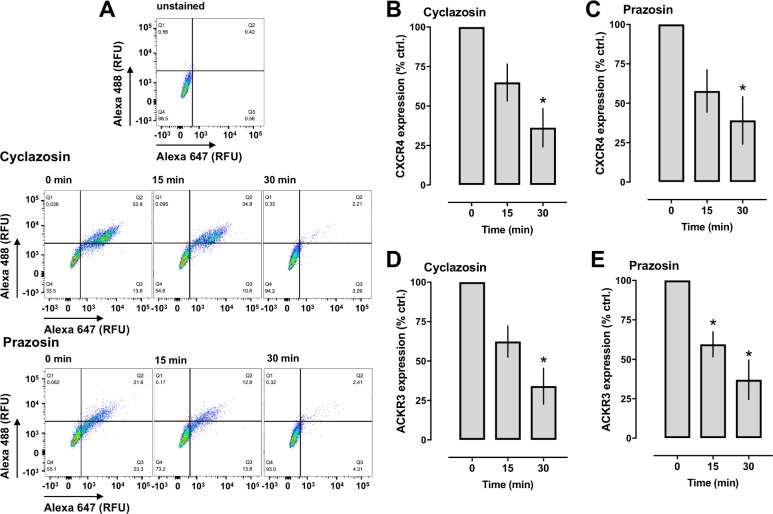
Prazosin and cyclazosin induce internalization of CXCR4 and ACKR3 in hVSMCs.A. hVSMC were treated with 100 μM cyclazosin or prazosin at 37°C for 15 or 30 min, stained with anti-CXCR4/Alexa 647-conjugated anti-rabbit and anti-ACKR3/Alexa 488-conjugated anti-mouse and analyzed for receptor expression via flow cytometry. RFU: relative fluorescence units. The horizontal and vertical lines show the gating thresholds for CXCR4 (Alexa 647) and ACKR3 (Alexa 488). B-E. Quantification of CXCR4 (B/C) and ACKR3 (D/E) cell surface expression by flow cytometry. Cells were stimulated with 100 μM cyclazosin (B/D) or prazosin (C/E) as indicated. Data are mean ± SE from 4 independent experiments. *: p<0.05 vs. t = 0 min.